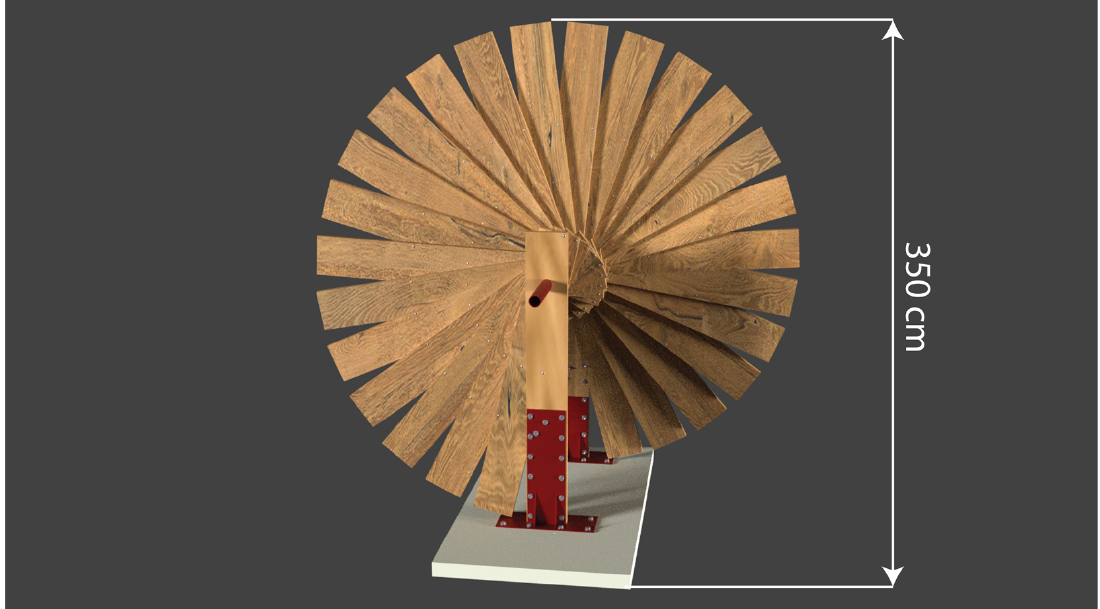
Figure 9. Final visualisation of the sculpture Transition, Ryszard Litwiniuk 2017 (authors of 3D model and visualization: Gaja Hanuna, Simon Perovnik, Nina Krpan).